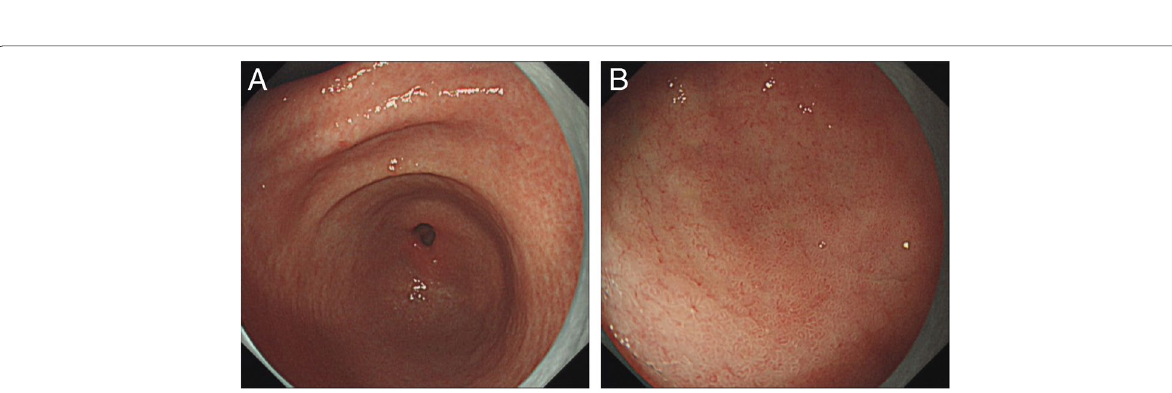
Fig. 5 Endoscopy after 7 months of anti-HP treatment: there was no significant abnormality in the mucosa of the gastric sinus ( A ), ulcerative scars were visible in the mucosa of the bulb ( B